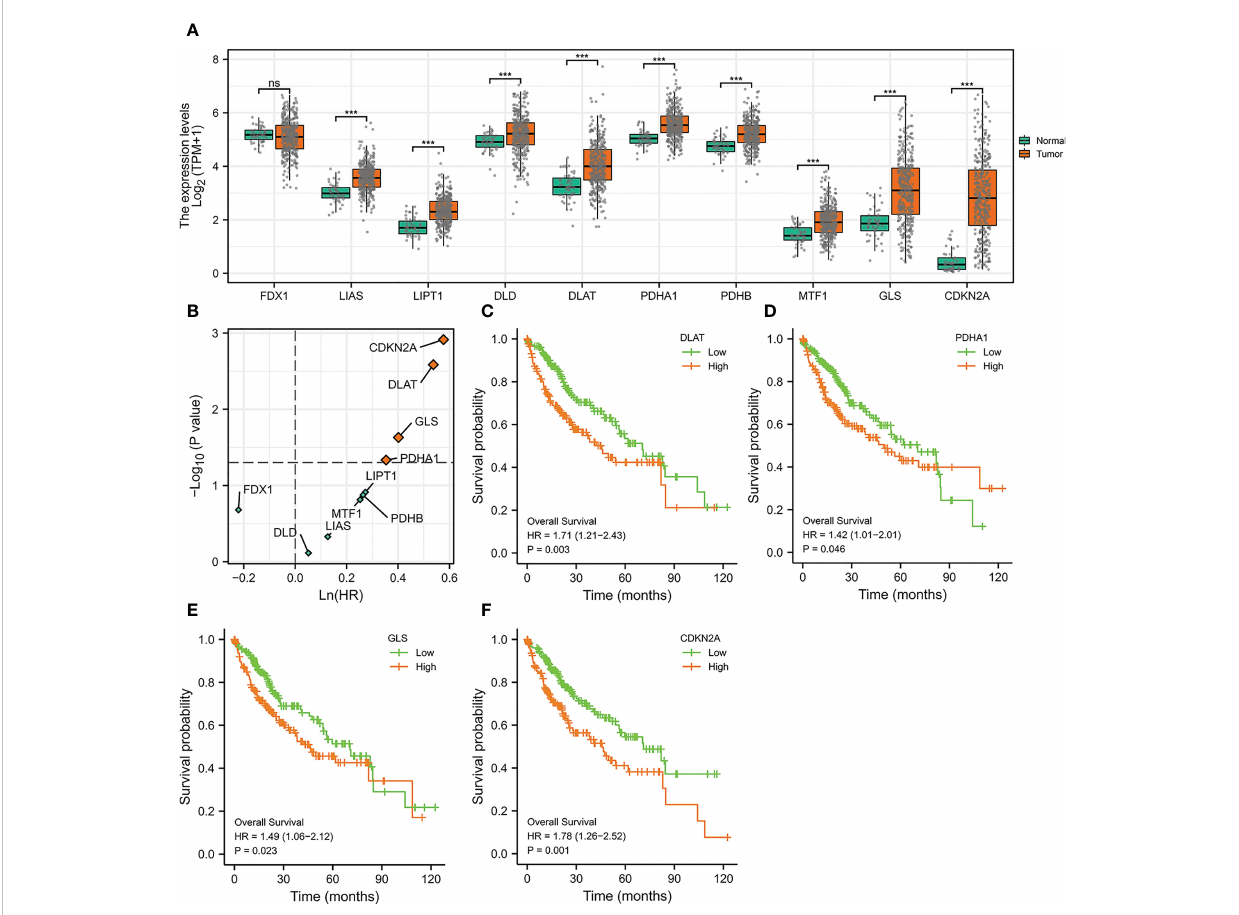
FIGURE 1 The Expressions and Prognosis Analysis of Cuproptosis-Related Genes in HCC. (A) Differential expression of cuproptosis-related genes in the TCGA- LIHC cohort. (***p<0.001; ns stands for not signi fi cant) (B) Correlation between cuproptosis-related gene expression and survival data (OS) of HCC patients. The horizontal dotted line stands for p=0.05. The vertical dotted line represents HR=1. (C – F) Kaplan-Meier curves of DLAT (C) , PDHA1 (D) , GLS (E) , and CDKN2A (F)